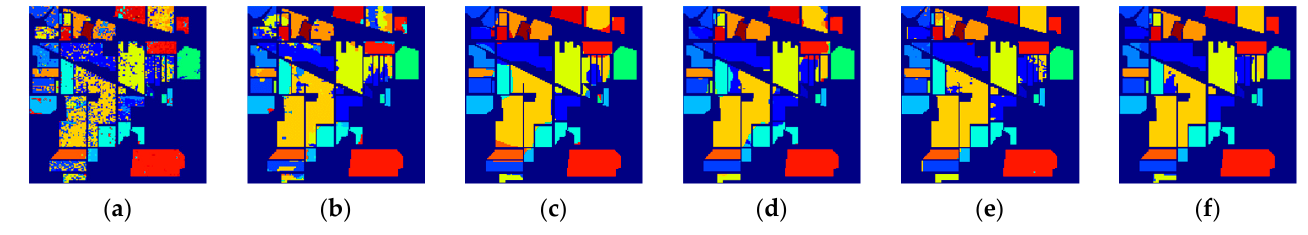
Figure 9. The predicted label images of different methods on IP: ( a ) SVM, ( b ) 3DCNN, ( c ) SSRN, ( d ) HybridSN, ( e ) SuperPCA, and ( f ) TBN-MERS.